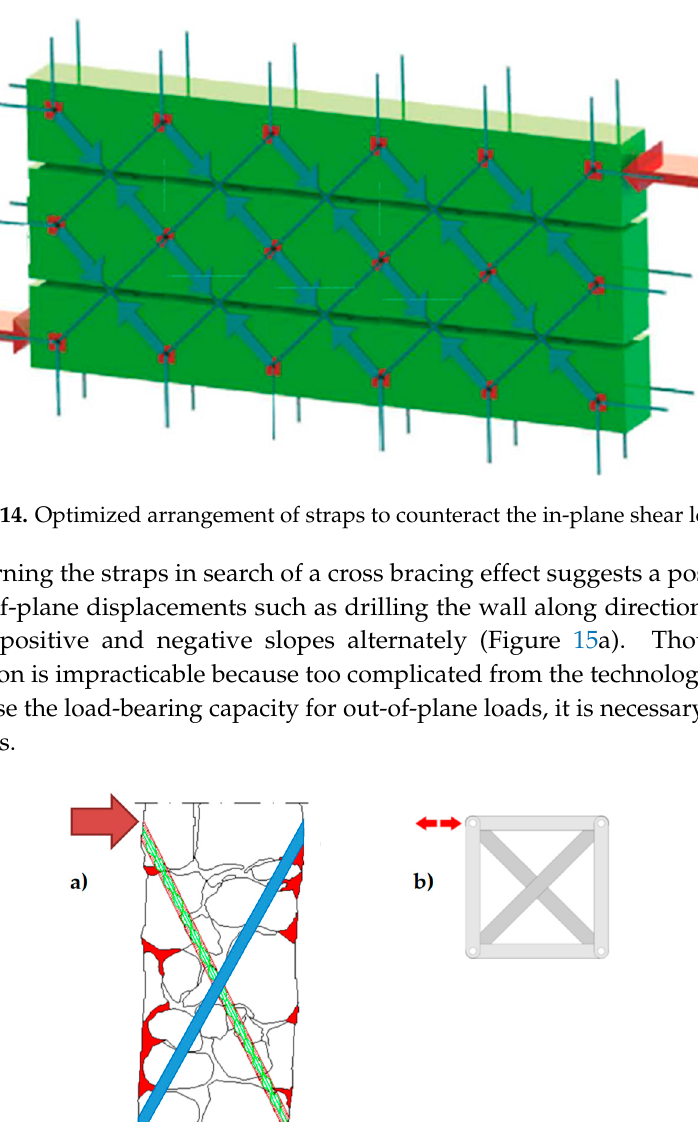
7 of 33 Figure 12. Hinged mechanisms between the ribbons of the CAM system: ( a ) in the wall thickness and ( b ) in the wall plane. Figure 13. Loading of an unreinforced masonry (URM) wall: ( a ) shear loading in the midplane and ( b ) out-of-plane loading. 3. Techniques of Cross Bracing in the Thickness of the Wall 3.1. Re-Arrangement of the CAM Straps As shown in Reference [15], it is possible to re-arrange the CAM straps to find a statically determined strap configuration for lateral loads, in order to increase the load-bearing capacity for shear loads. In fact, arranging the straps along the two principal directions of stress for shear stress – which form angles of ±45° with respect to the horizontal direction [16] – provides a cross bracing effect in the plane of the wall (Figure 14). The idea of turning the straps in search of a cross bracing effect suggests a possible application